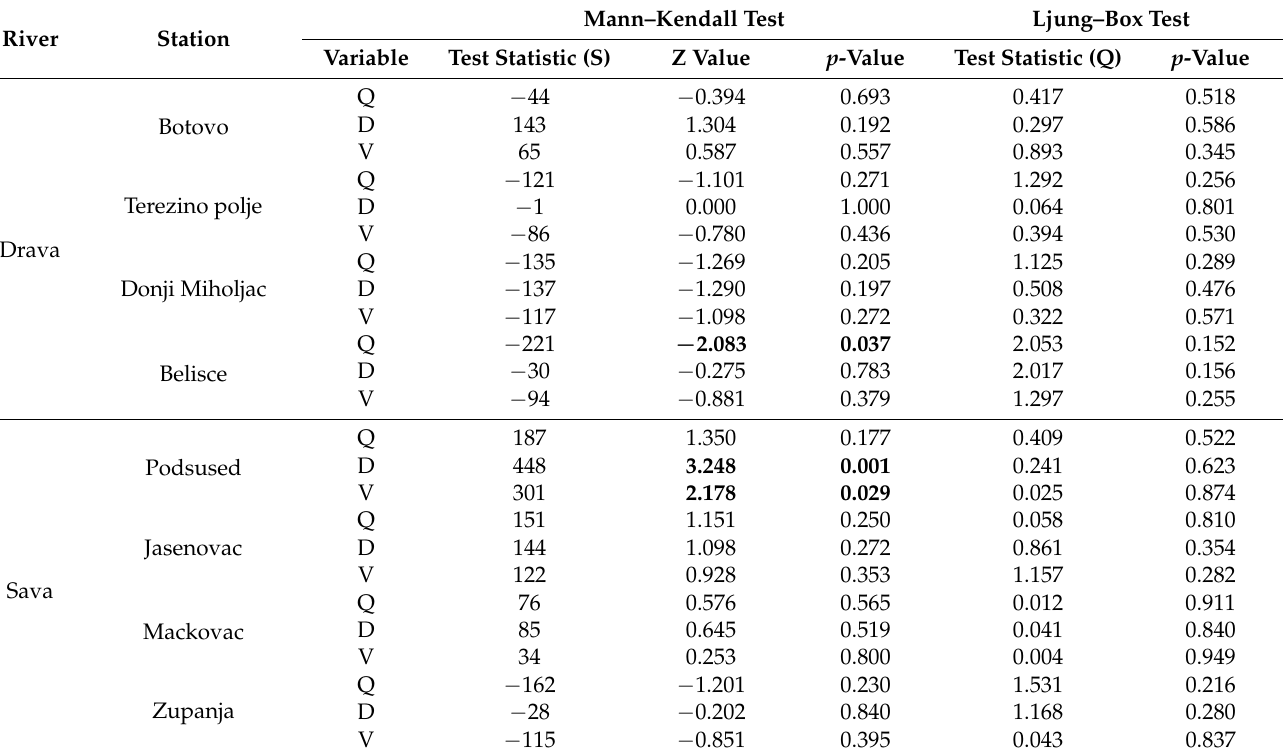
Table 6. The Mann–Kendall and Ljung–Box test results for Q, V and D variables.